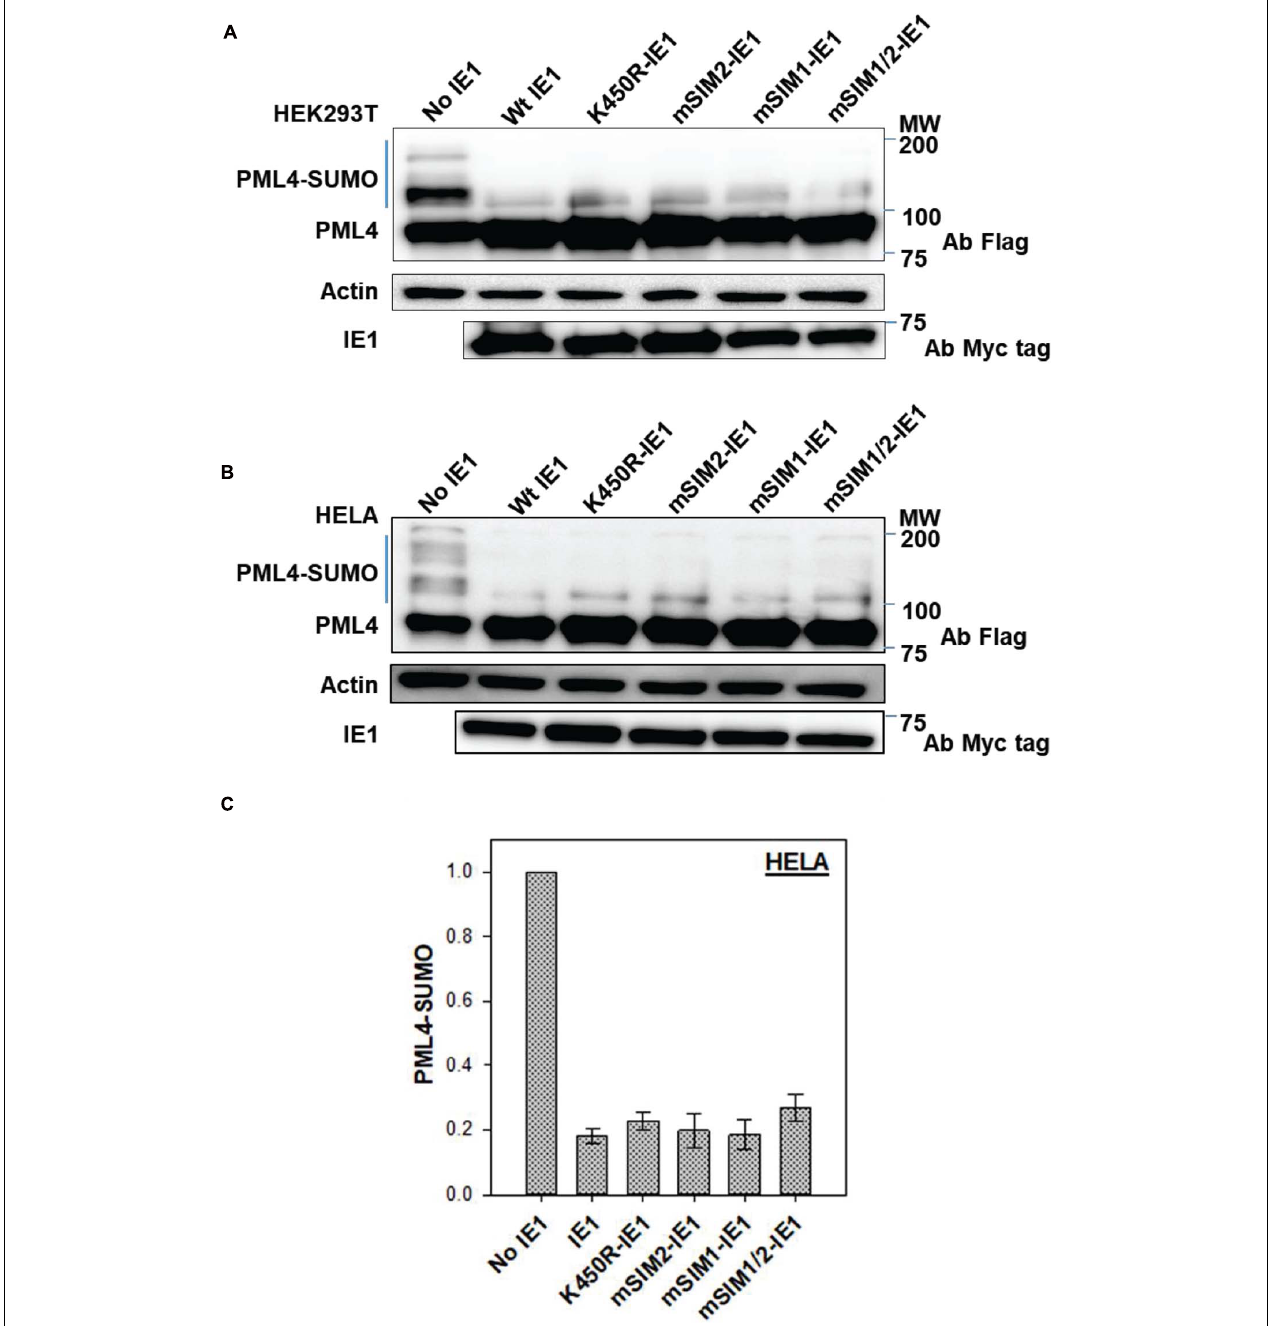
FIGURE 3 | Inhibition of PML SUMOylation by IE1. (A) HEK- 293T cells were transfected with Flag-PML IV either without IE1 or with different IE1 mutants, as mentioned. Cells were lysed 40–48 h post-transfection. The lysate was resolved on 8% denaturing SDS PAGE and blotted with anti-Flag antibody. (B) HeLa cells were transfected and processed as mentioned for HEK 293T. (C) Blots from HeLa [as in (B) ] were used to quantify PML SUMOylation in the presence of various mutants of IE1.